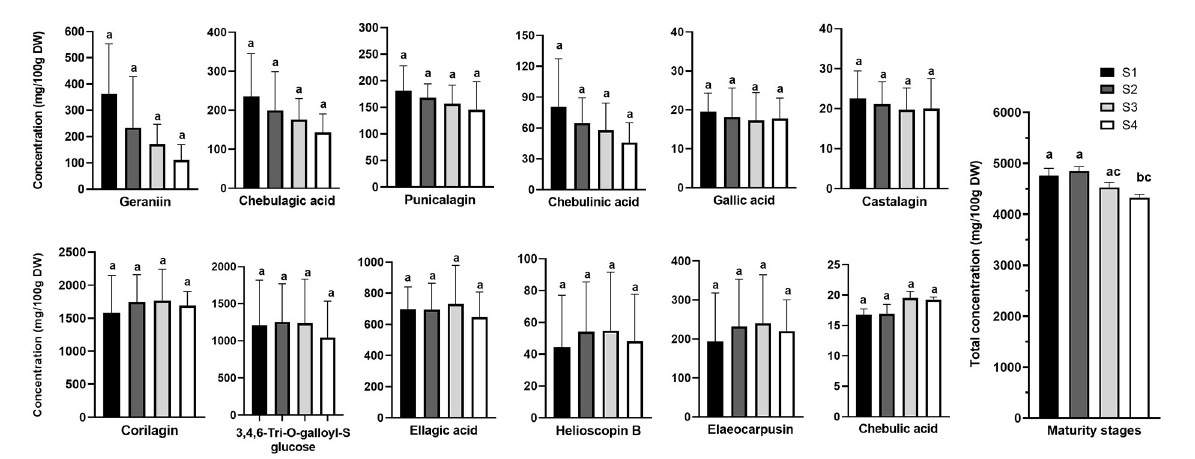
FIGURE4 Changes in the concentrations of the study bioactive compounds in Kakadu plum fruit harvested at different maturity stages. Data presents mean ± SE, n = 6. S1–4 denotes different fruit maturity stages classified from immature stage (S1) to fully mature stage (S4). Different letters indicate the significant differences at p ≤